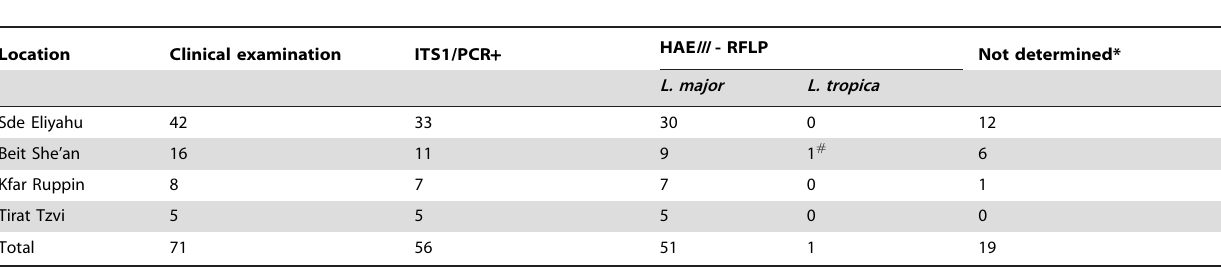
Table 2. Diagnosis of CL cases from the Beit-She’an Valley (2007–2011).